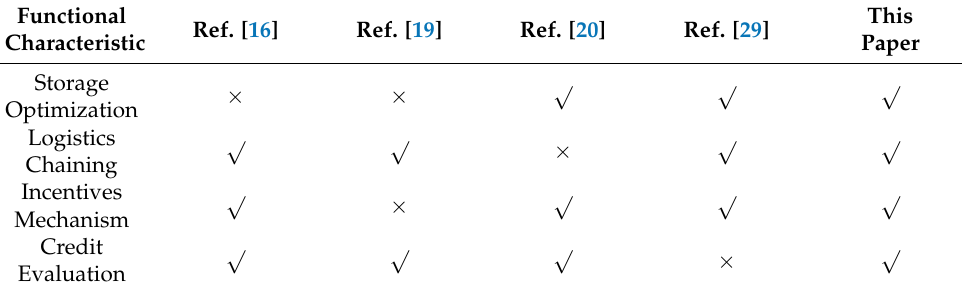
Table 2. Functional comparison of e-commerce system.